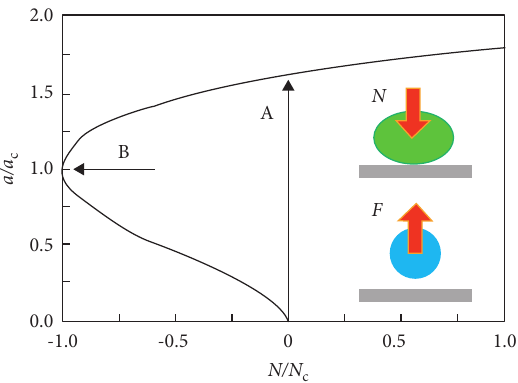
Figure 5: Variation of contact radius with load in JKR